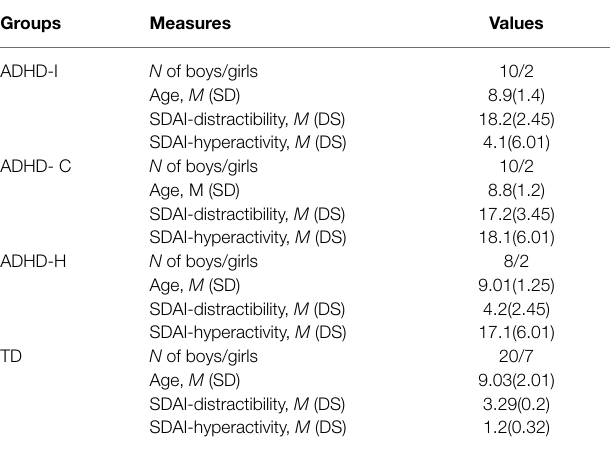
TABLE 1 | Characteristics of the